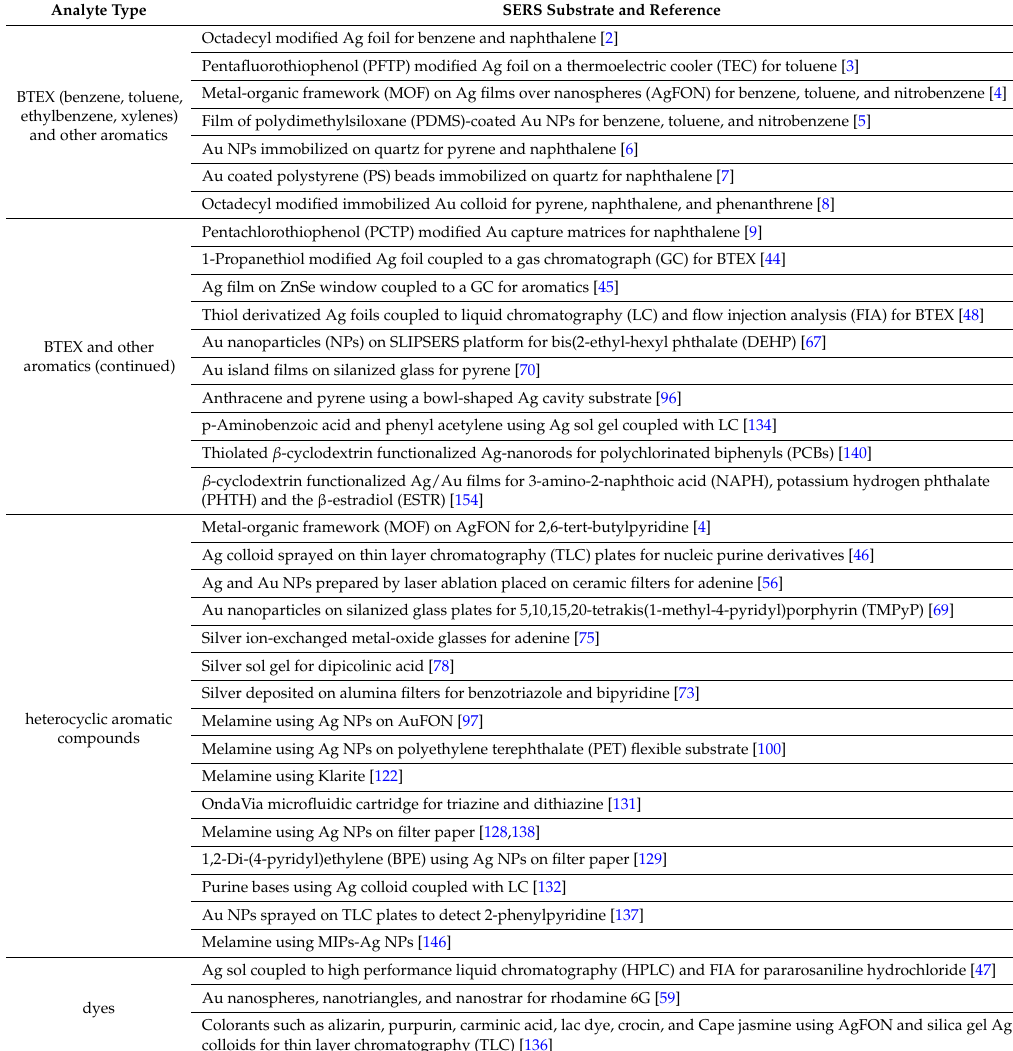
Table 2. Summary of SERS substrates and analytes discussed in this